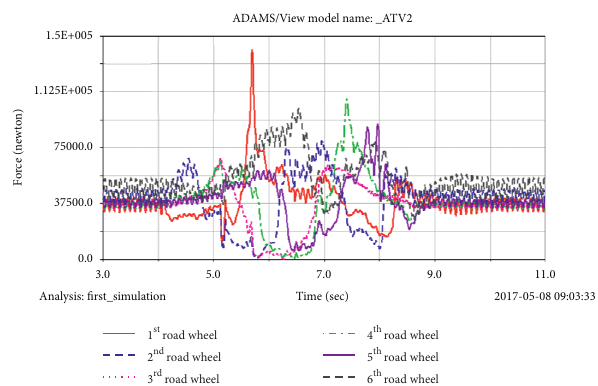
Figure 12: Vertical load of each road wheel in the process of crossing the trench.